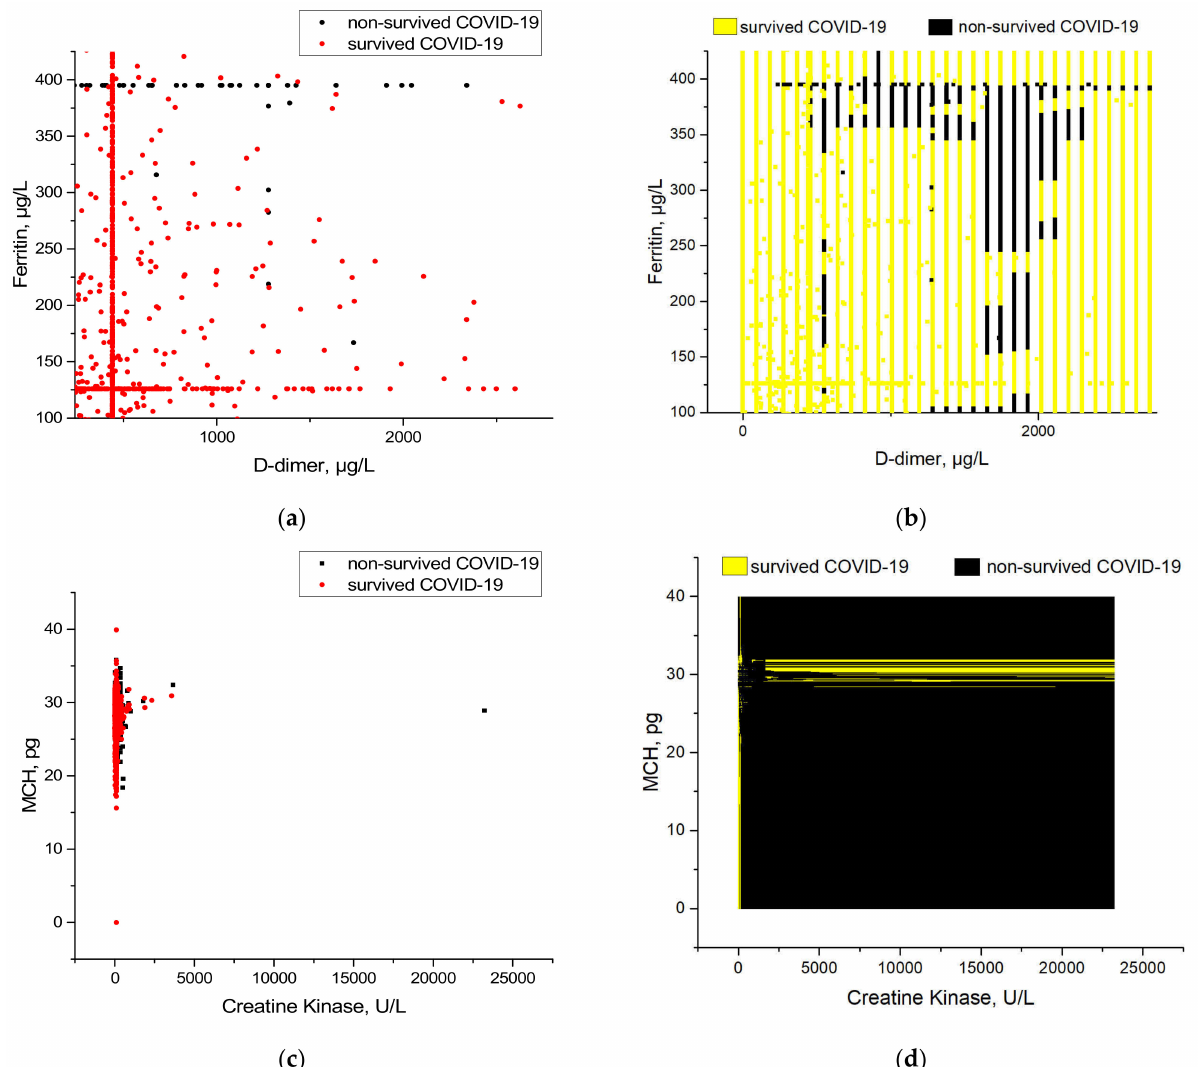
Figure 14. Distributions of non-surviving and surviving COVID-19 patients over the original data on D-dimer-ferritin ( a ) and CK-MCH ( c ) feature pairs. The 2D-masking technique for patient-group classification of the HGB model operated with D-dimer-ferritin ( b ) and CK-MCH ( d ) feature